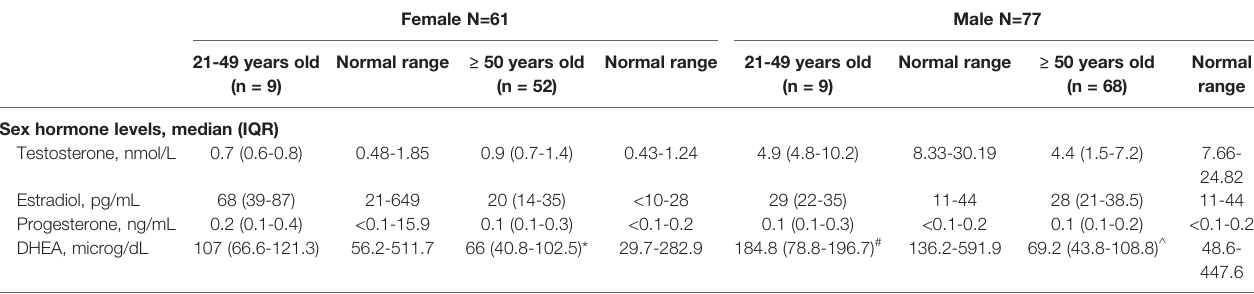
TABLE 1 | Median sex hormone levels of 138 patients, strati fi ed by sex and